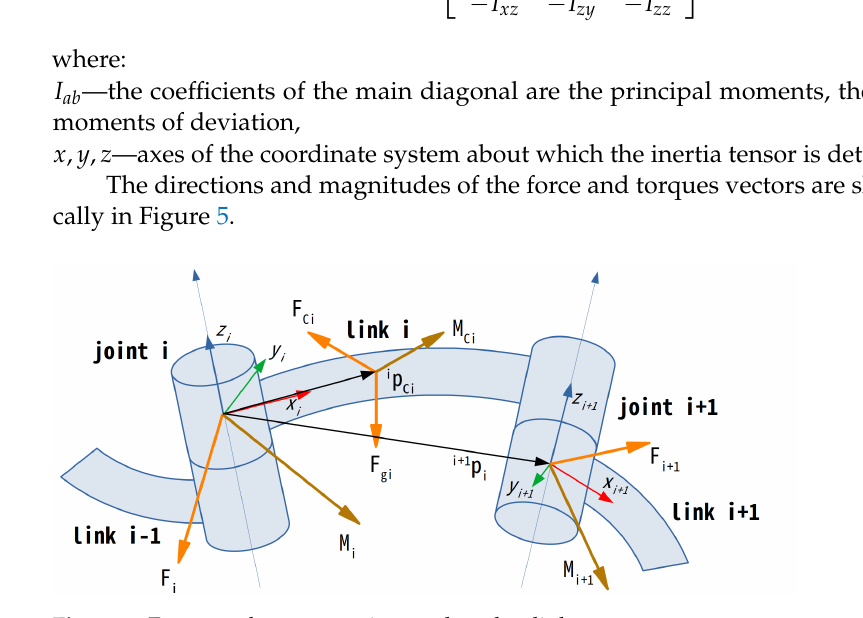
Figure 5. Forces and torques acting on the robot